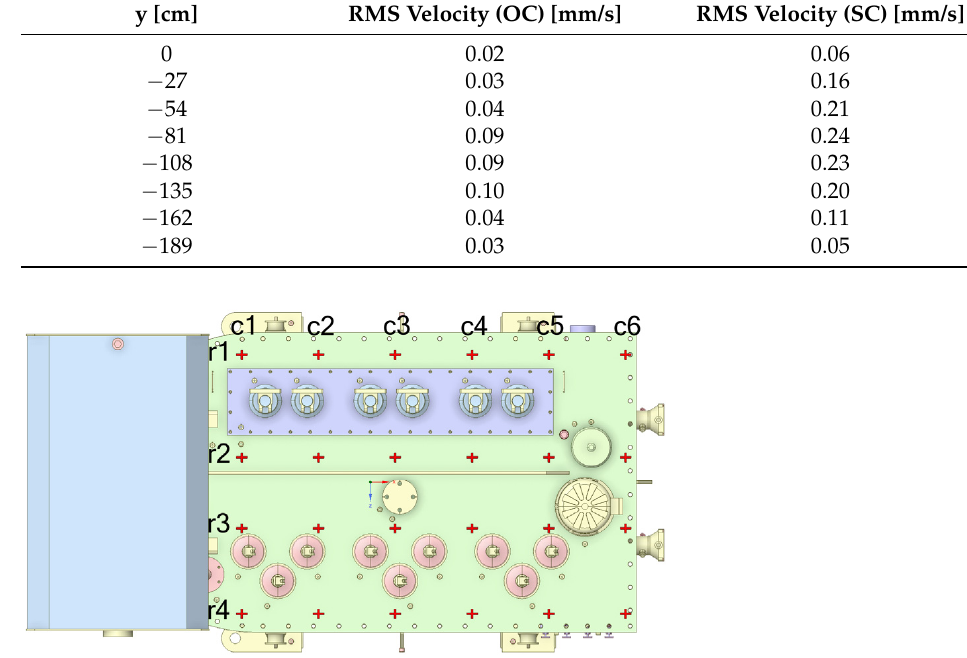
Figure 15. CAD model of the transformer experimental model in the top view with marked points of vibration measurements (red crosses) on the tank cover.